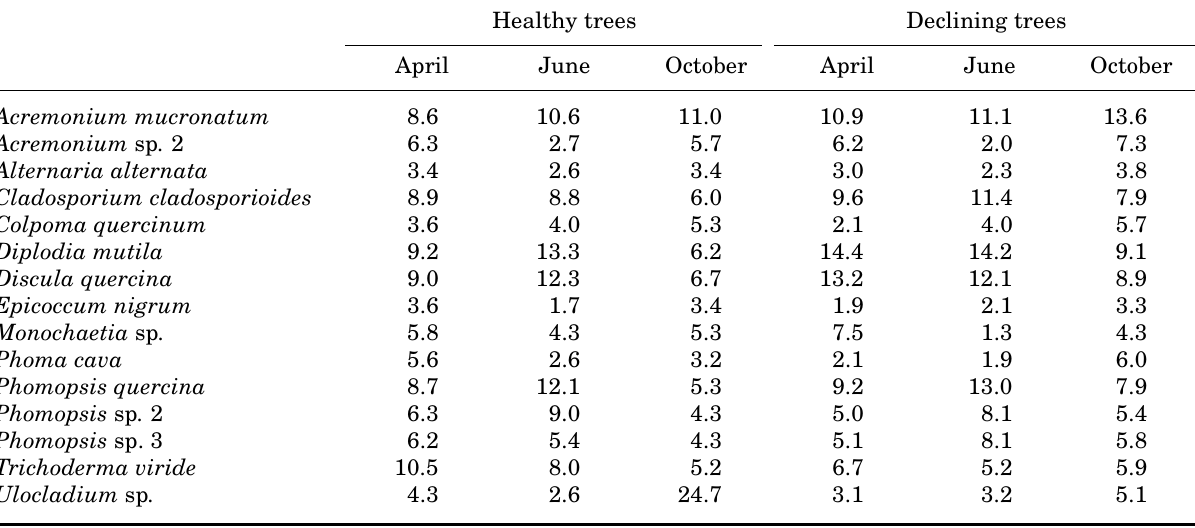
Table 2. Isolation frequency of fungal species from healthy and declining Quercus cerris trees at three sampling dates in 1999 and 2000. Data are percentages of each fungus over total fungi isolated from that organ summing data of all sampling